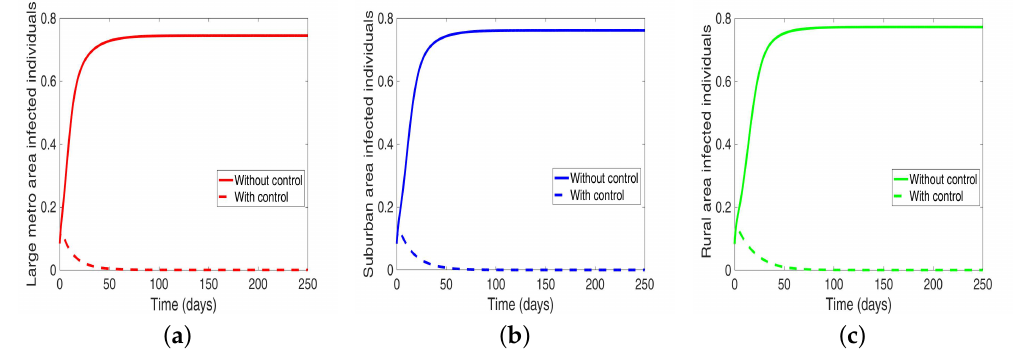
Figure 13. MRSA model simulation with movement, disease and behavioral control in large metro area only. ( a ) Infected individuals in large metro area. ( b ) Infected individuals in suburban area. ( c ) Infected individuals in rural area. Parameter values used are given in Tables